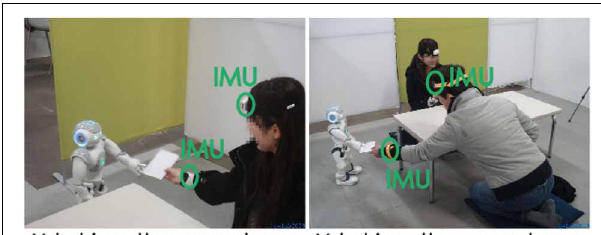
FIGURE 1 | The experimental set-up. Participant X takes the envelope from NAO. Participant Y leans forward and extends his arm in order to grasp the envelope that NAO is handing